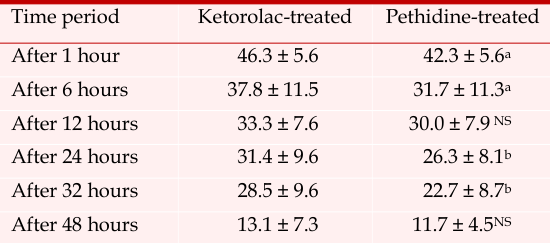
Assessment of post-operative pain relief by VAS score